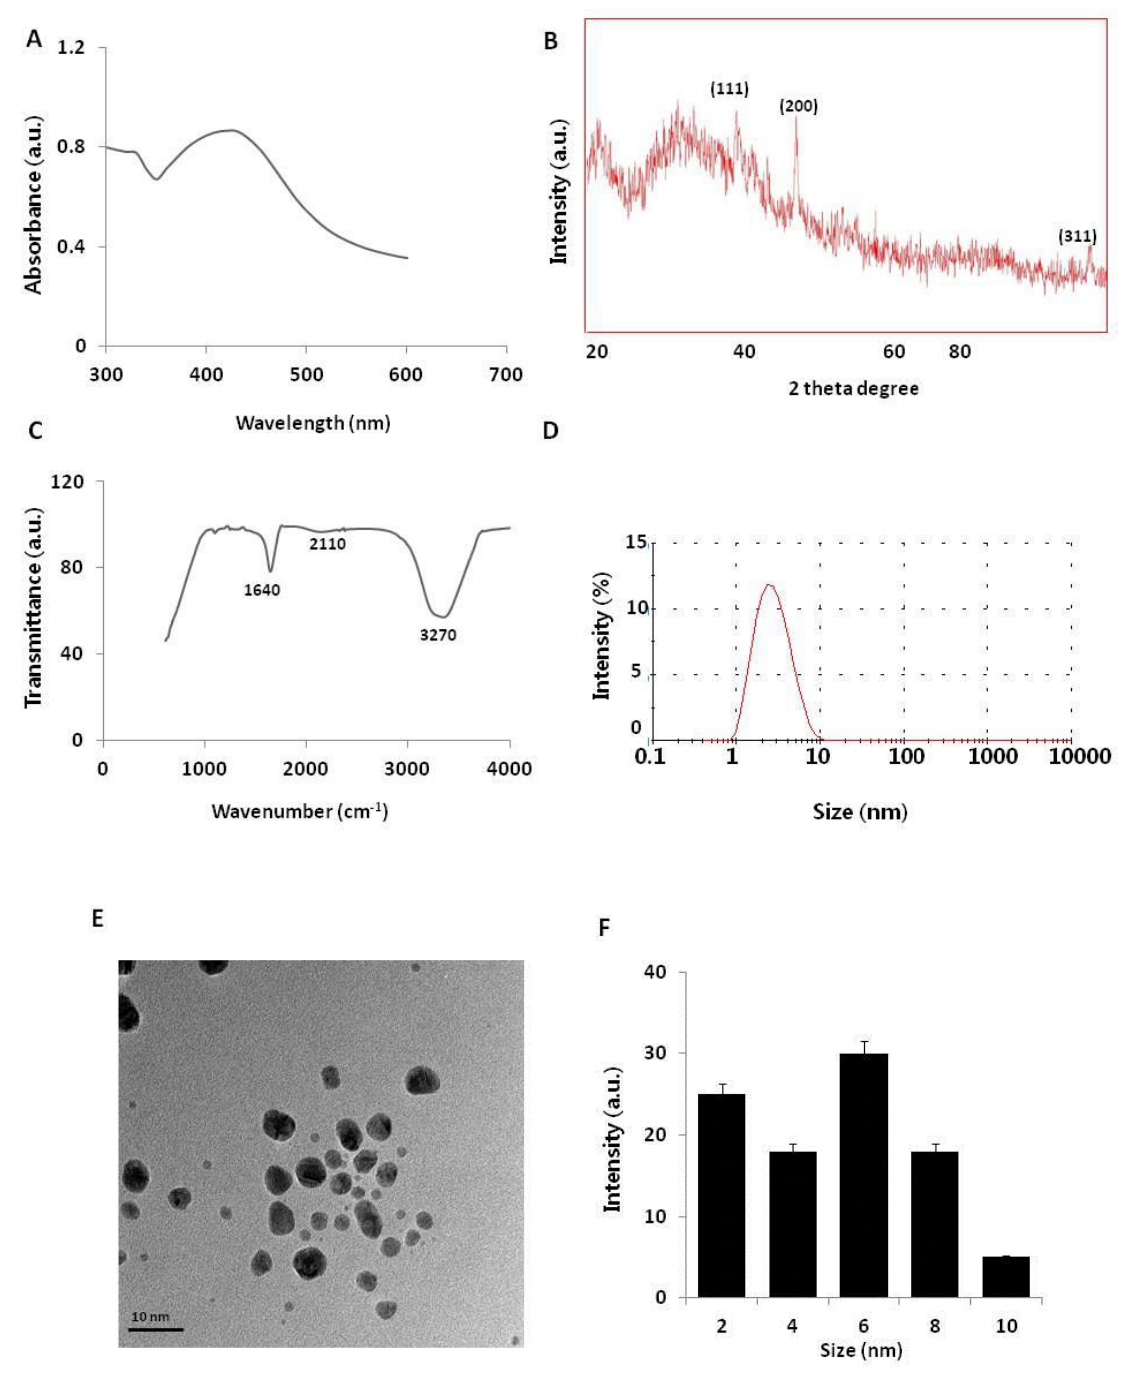
Figure 1. Synthesis and characterization of silver nanoparticles (AgNPs). ( A ) Ultraviolet–visible (UV–vis) spectra of AgNPs. ( B ) X-ray diffraction (XRD) pattern of AgNPs. ( C ) Fourier-transform infrared (FTIR) spectra of AgNPs. ( D ) Size distribution analysis of AgNPs using dynamic light scattering (DLS). ( E ) TEM images of AgNPs. ( F ) Particle size distributions from TEM images. The diameter of AgNPs was determined from more than 200 particles.